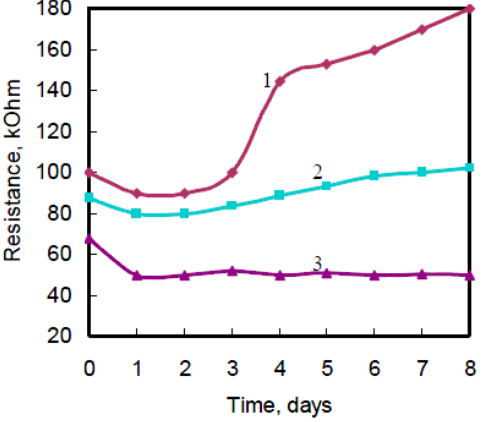
Figure 5. Typical dependence of emeraldine state films activated with H 6 P 2 W 18 O 62 on applied voltage at room temperature: 1–0.1 V; 2–0.05 V; 3–0.01